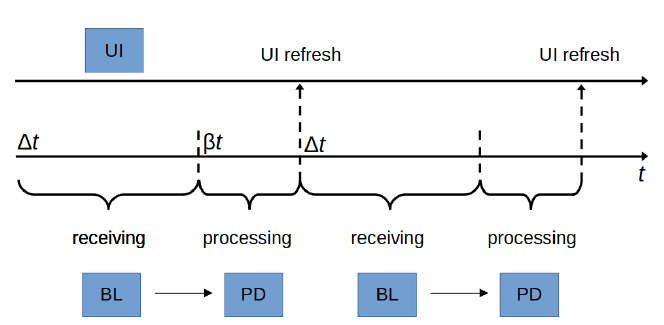
Figure 2. Interactions between the BL and PD services.